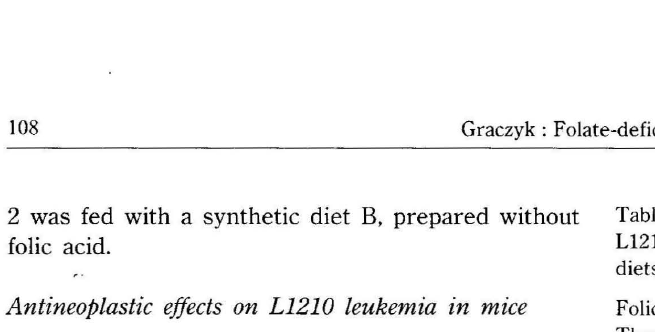
Table 1. Effects of FU on the survival of mice with leukemia Ll210 after 14 days of folic acid-replete and folic acid-deficient